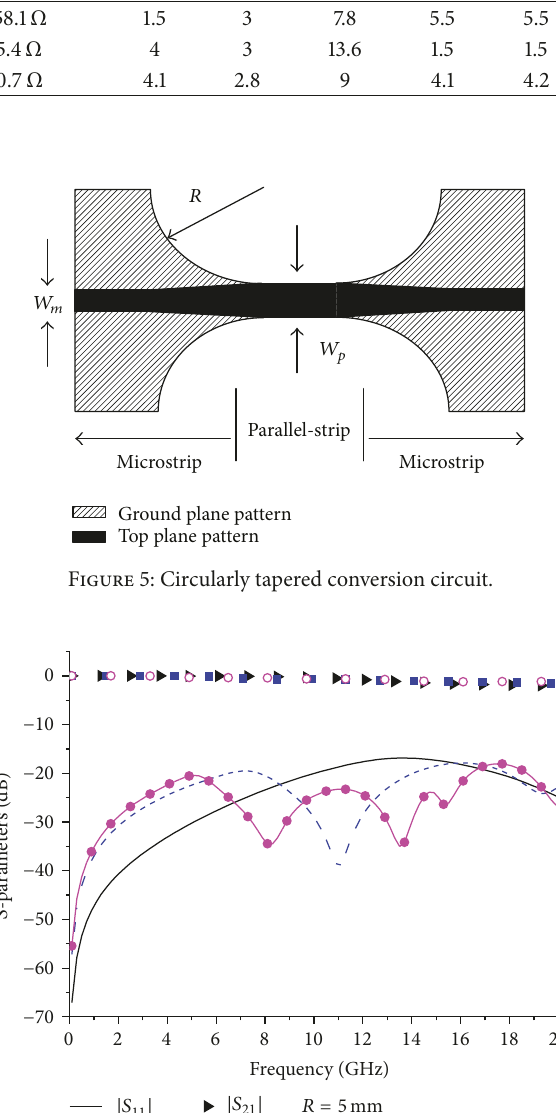
radius 𝑅 = 5 mm is chosen for circularly tapered conversion